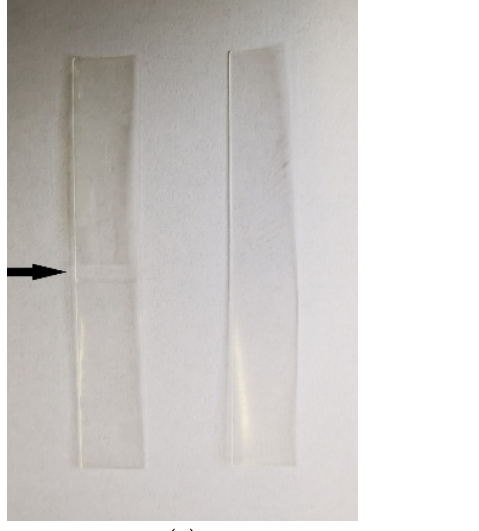
Figure 5. ( a ) Tensile strength and ( b ) elongation to break of the original formulations and the suc- cessfully prepared tandem films ( n = 6, mean ± sd). The PVA films did not rip until reaching the tensile tester´s maximum distance (elongation > 300%).